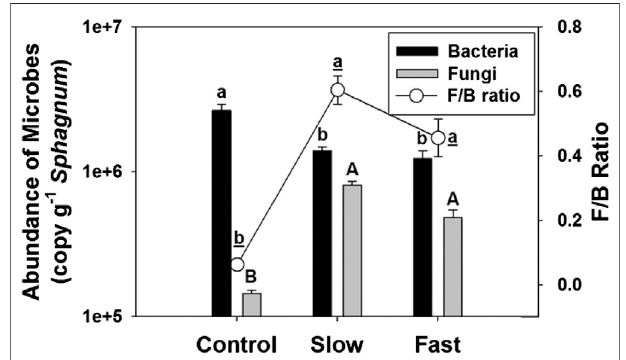
FIGURE 3 | Abundance of fungi (fungal ITS) and bacteria (bacterial 16S rRNA) (bar), and F/B ratio (line) on Sphagnum surface. Letter denotes statistically signi fi cant differences between treatments (n (cid:2) 24, p < 0.05).